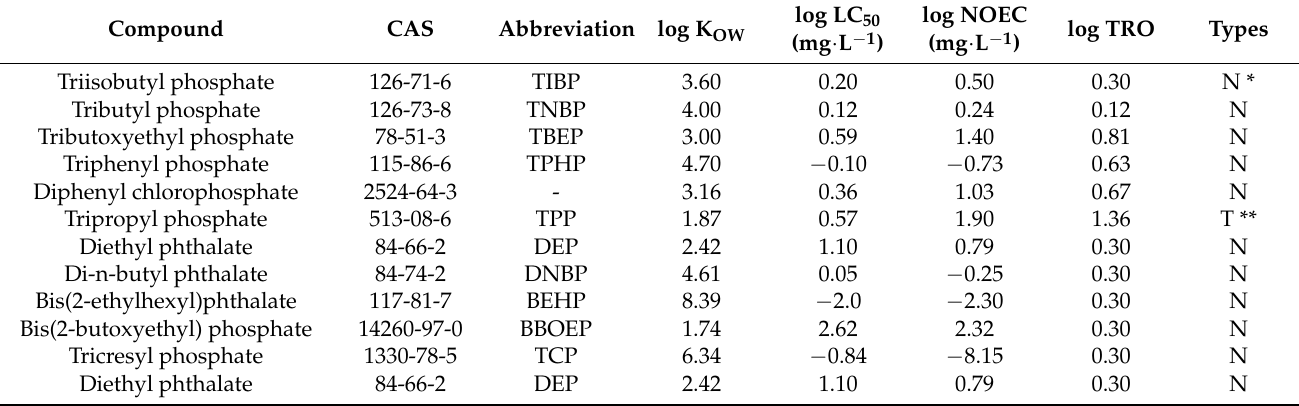
Table 2. Information on related parameters of